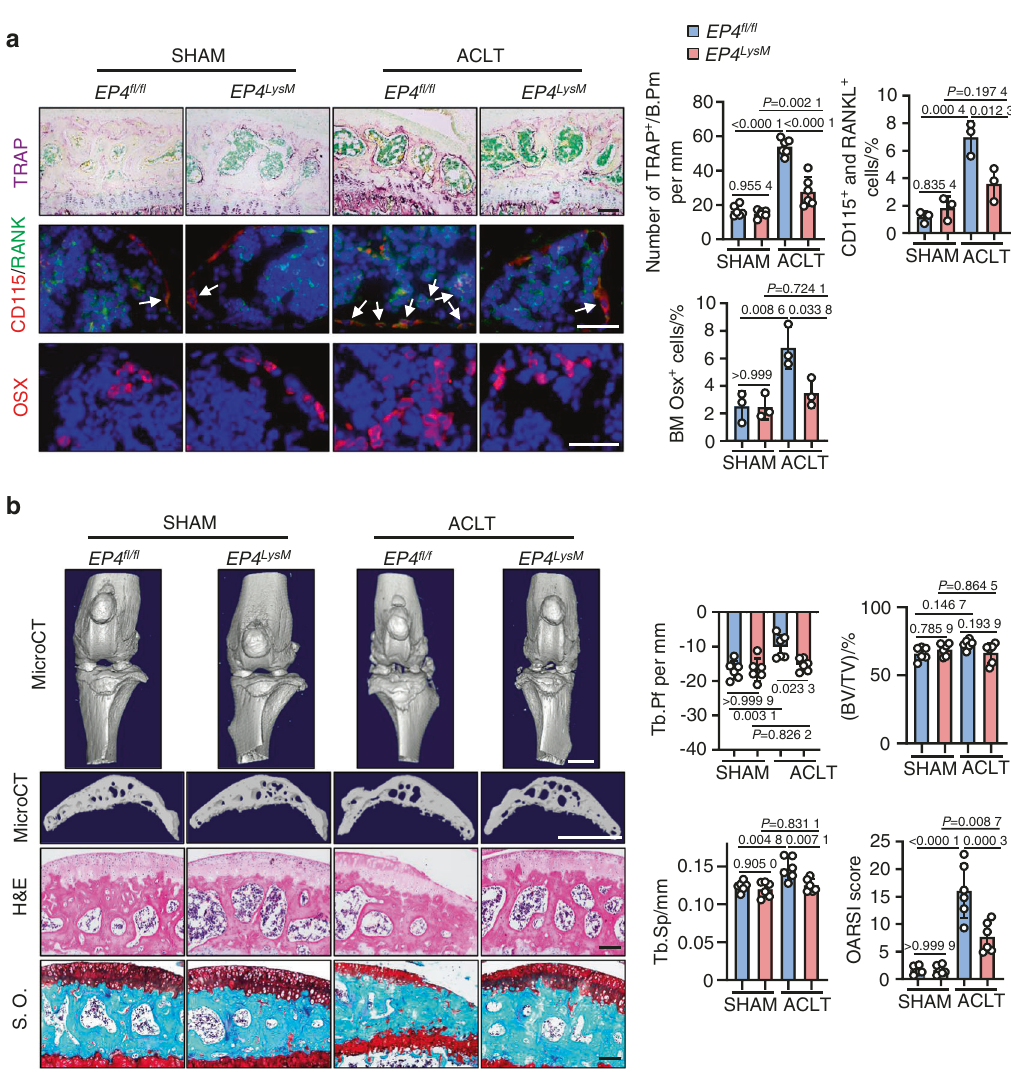
Fig. 2 EP4 deletion in osteoclasts inhibits OA progression in a murine OA model. a Representative images of TRAP staining and IHF staining of Osterix (Osx), CD115 (red), and RANK (green) in the subchondral bone of the EP4 fl / fl or littermate EP4 LysM mice post-ACLT surgery (top) and quantitative analysis (bottom). TRAP staining, IHF staining of CD115 and RANK, and IHC staining of Osx were performed 2 weeks after ACLT surgery. The white arrow indicates CD115 and RANK double-positive osteoclast precursors. Error bars are the mean ± s.d. Two-way ANOVA followed by Tukey ’ s t tests. n = 6 for TRAP staining, n = 3 for CD115 and RANK IHF staining. Scale bars, 50 μ m (TRAP staining), 20 μ m (CD115 and RANK IHF staining), and 20 μ m (Osx IHF staining). b Representative 3D reconstructed microCT images, H&E staining, and safranin O-fast green (S.O.) staining of sagittal sections of articular cartilage of the EP4 fl / fl or littermate EP4 LysM mice 8 weeks after ACLT surgery (left). Quantitative analysis of structural parameters of subchondral bone, including Tb.Pf, Tb.Sp and BV/TV. OARSI scores based on the S.O. staining histology analysis (right). Error bars are the mean ± s.d. n = 6 for each group. Two-way ANOVA followed by Tukey ’ s t tests. Scale bars, 1 mm (microCT), 50 μ m (S.O.) and 50 μ m corroborated in an in vivo setting, with Netrin-1 expression being signi fi cantly lower in the subchondral bone marrow of the EP4 LysM mice following ACLT ( P < 0.05) than in that of the EP4 fl / fl mice (Fig. 3e). The CGRP-positive sensory neurons that may mediate OA- related pain were also signi fi cantly lower in the subchondral bone marrow of the EP4 LysM mice than in that of the EP4 fl / fl mice ( P < 0.01; Fig. 3f). Thus, the data suggest that the reduction in OA- related pain observed in the EP4 LysM mice may partly be due to the